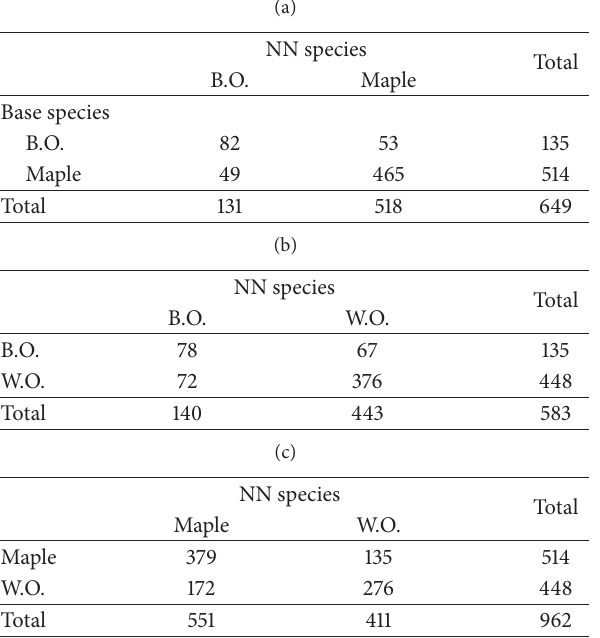
Table 18: The (reduced) Q -symmetry contingency tables for the restricted pairwise analysis for the Lansing Woods data. The relative frequencies in parentheses are with respect to the row sums. B.O. stands for black oaks, M. for maples, and W.O. for white oaks.